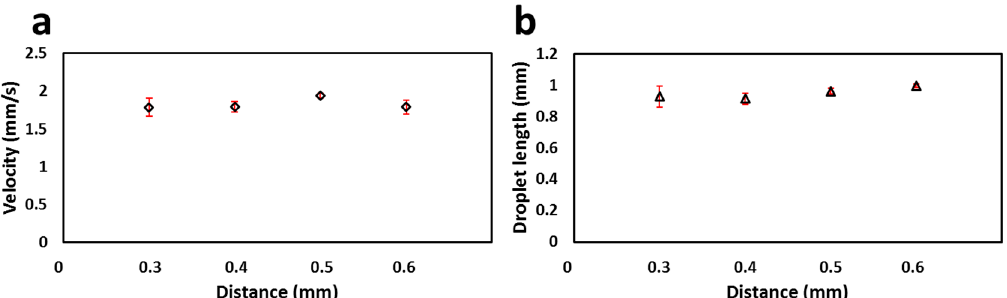
Figure 3. Droplet velocity and length measurements in dual light paths with different distances ( L = 0.3, 0.4, 0.5, and 0.6 mm): ( a ) Velocity measured by flow cell with a dual light path using different L values; ( b ) Droplet length measured by the flow cell using different L values. Both droplet velocity (1.65 mm/s) and length (0.94 mm) were measured to be similar with %RSD values of 3% and 4% respectively.